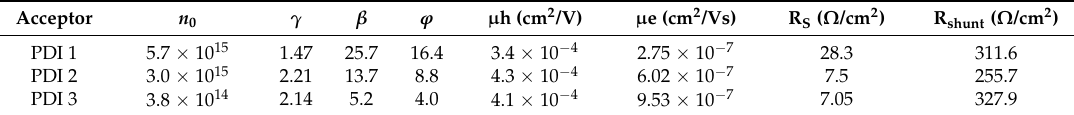
Table 2. Values of recombination parameters and hole and electron mobility derived from charge extraction/transient photovoltage (CE/TPV) measurements and SCLC.